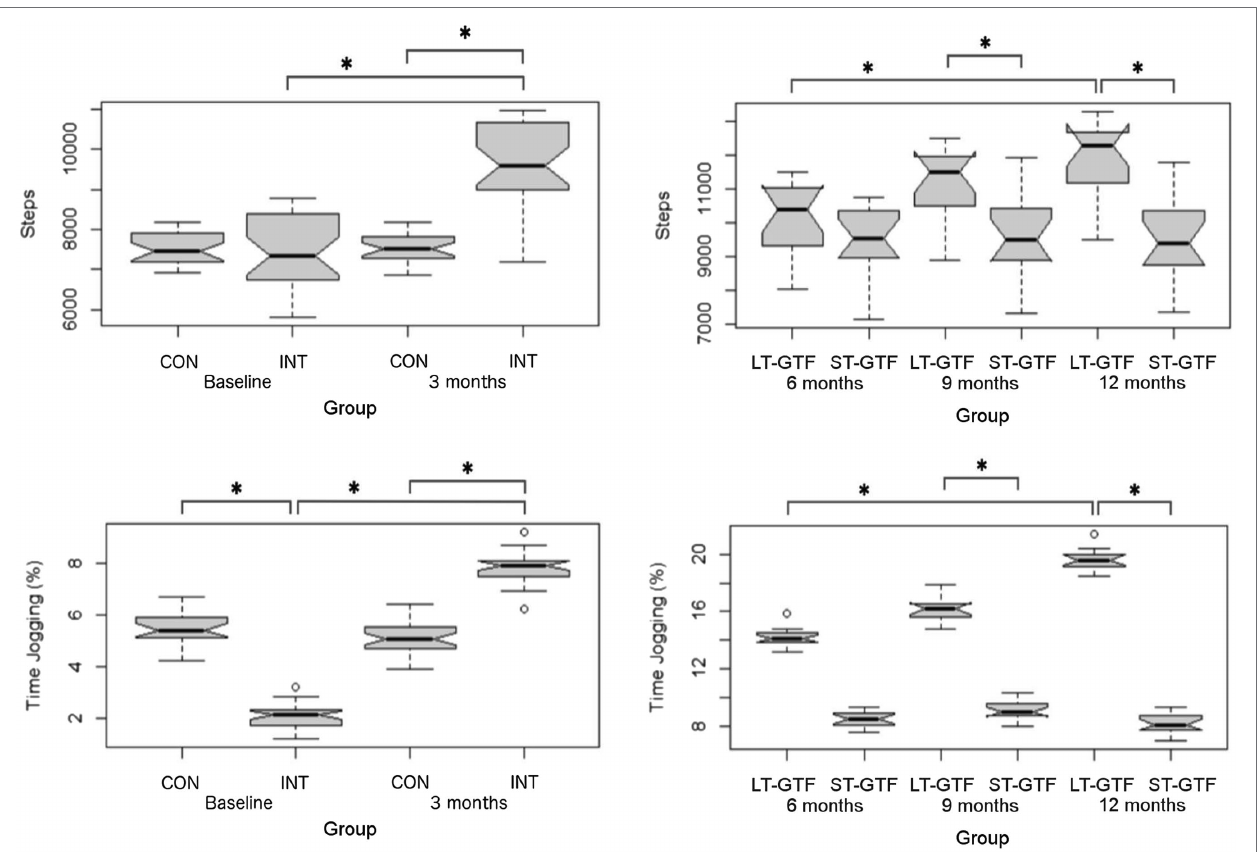
FIGURE 5 | Physical activity measurements (Step Count, % Time Jogging). Graphs on the left represent control (CON) and intervention (INT) groups from baseline to month 3. Graphs on the right represent measurements taken at 6, 9, and 12 months. LT-GTF, Long-term GTF group; ST-GTF, Short-term GTF. * Represent statistically significant